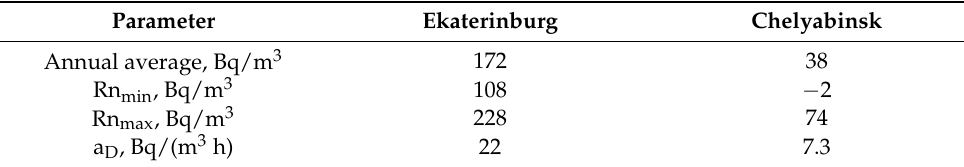
Table 8. Estimated parameters of the